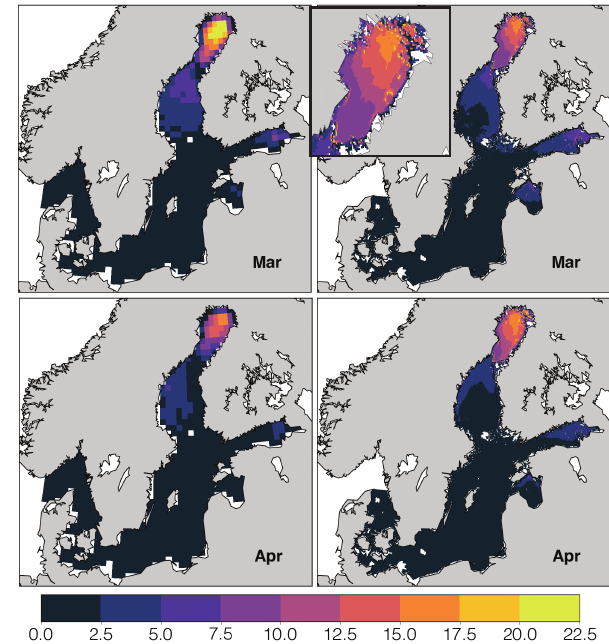
Figure 11. Climatological mean sea-ice thickness in centimeters for March and April, for the period 1961/1962–1978/1979. The left (right) column shows sea-ice thickness for BASIS (NEMO-Nordic). For NEMO-Nordic the mean sea-ice thickness represents a proxy level ice thickness and is calculated using a category-weighted av- erage of the first four ice categories; see Eq. (4). Note that grid cells with an ice concentration lower than 15% have been masked out.